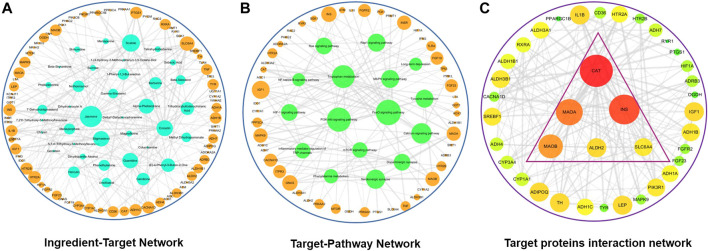
Tryptophan metabolism network diagrams after HLJDD treatment. (A) HLJDD active ingredient-target network associated with tryptophan metabolism; (B) HLJDD target-pathway network associated with tryptophan metabolism; (C) Core HLJDD target proteins interaction network associated with tryptophan metabolism.